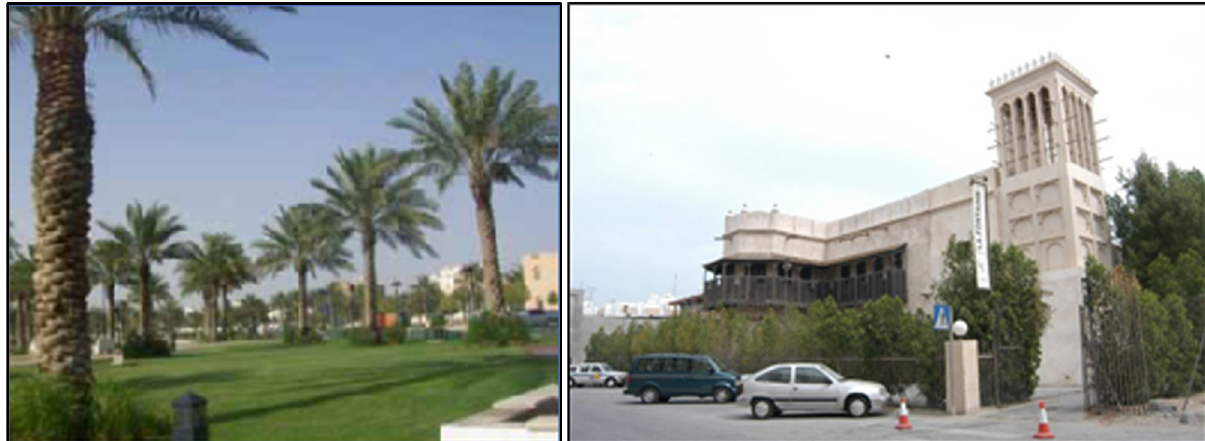
Fig. 5. Such landscape in harsh climate is available thanks to recycled treated water. Conservation, rehabilitation, traditional buildings and buildings converted to decent activities are parts of sustainable policy